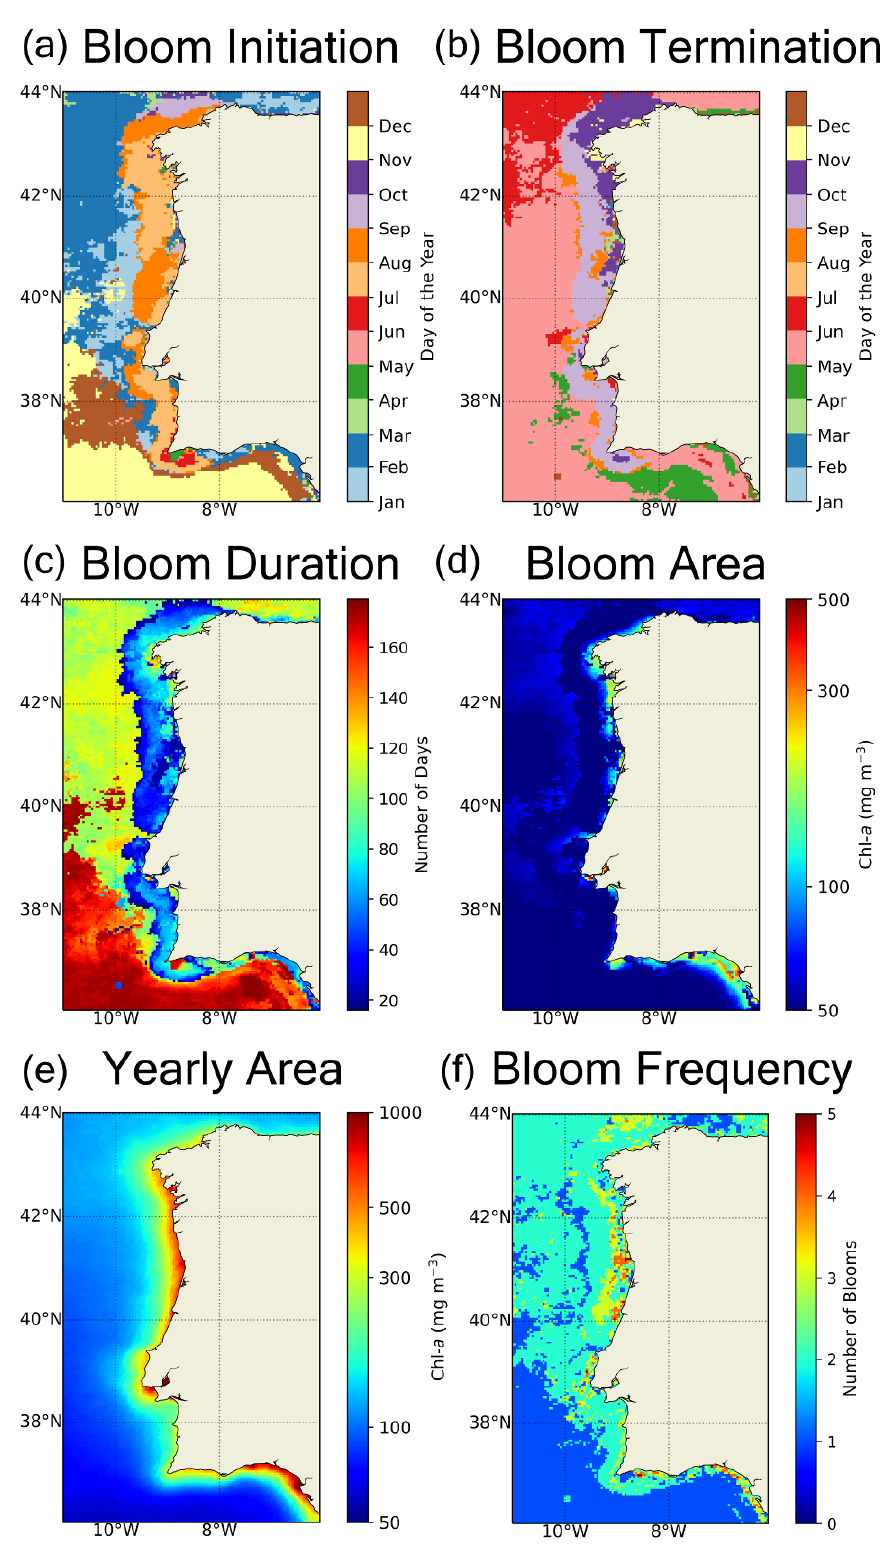
Figure 5. Mean dates of ( a ) main bloom initiation and ( b ) termination; ( c ) mean bloom duration; ( d ) mean area (mg m − 3 ); ( e ) mean yearly area (mg m − 3 ); and ( f ) mean bloom frequency (blooms year − 1 ) during 1997 – 2018.